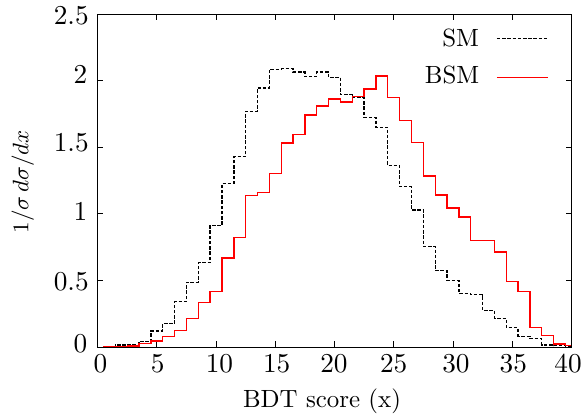
Figure 2 . BDT score variable used in the asymmetry determination as described in the text.